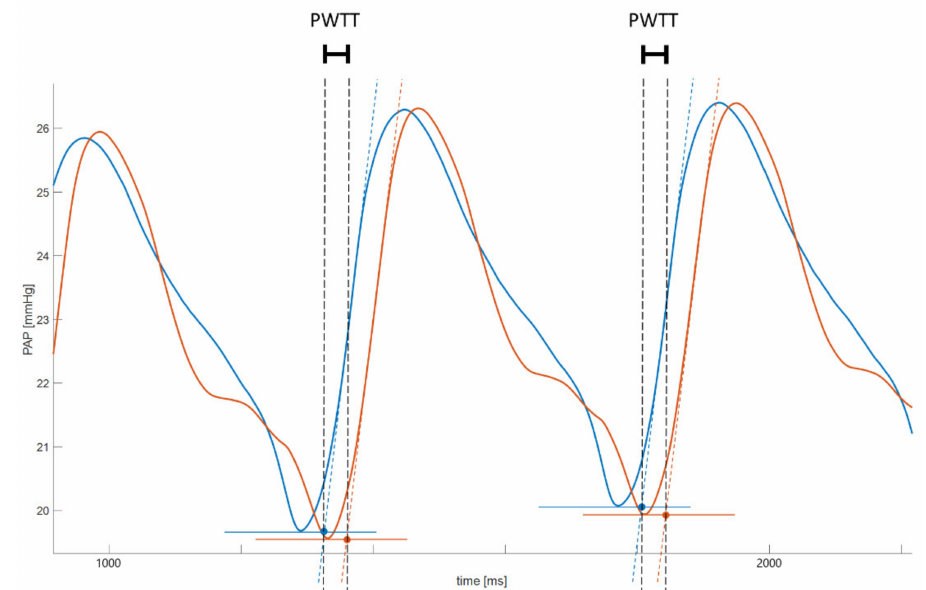
Figure 3. The pulse wave transit time between the proximal and distal pulmonary artery. The proximal pressure curve of the pulmonary artery is shown in blue, the distal one in red. Solid lines represent the pulmonary artery pressure in mmHg. Local pulse arrival was determined by intersection of the tangent of the local maximum derivative (dotted lines in blue and red) and the previous dPAP. Pulse wave transit time (PWTT) was calculated as the time difference between selected pulse arrival from the proximal and distal pressure curve (black dotted